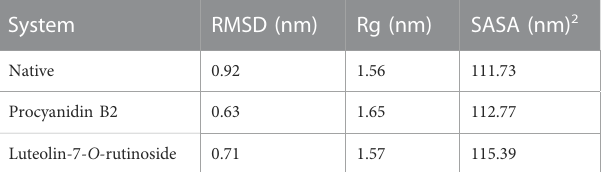
TABLE 3 The average RMSD, Rg, and SASA of the native and ligand-protein complexes.